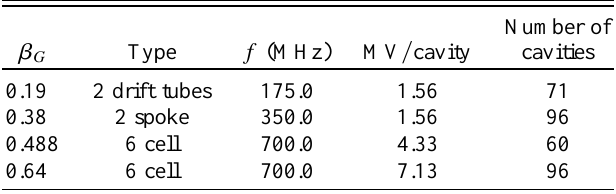
TABLE I. ANL driver linac resonator configuration (post- stripper section).